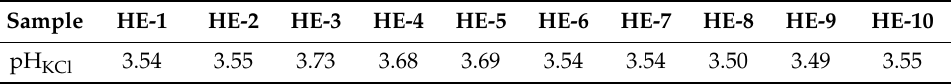
Table 3. Ultra-acidic and extremely acidic pH of the Histosol KCl-extract (HE). Sample